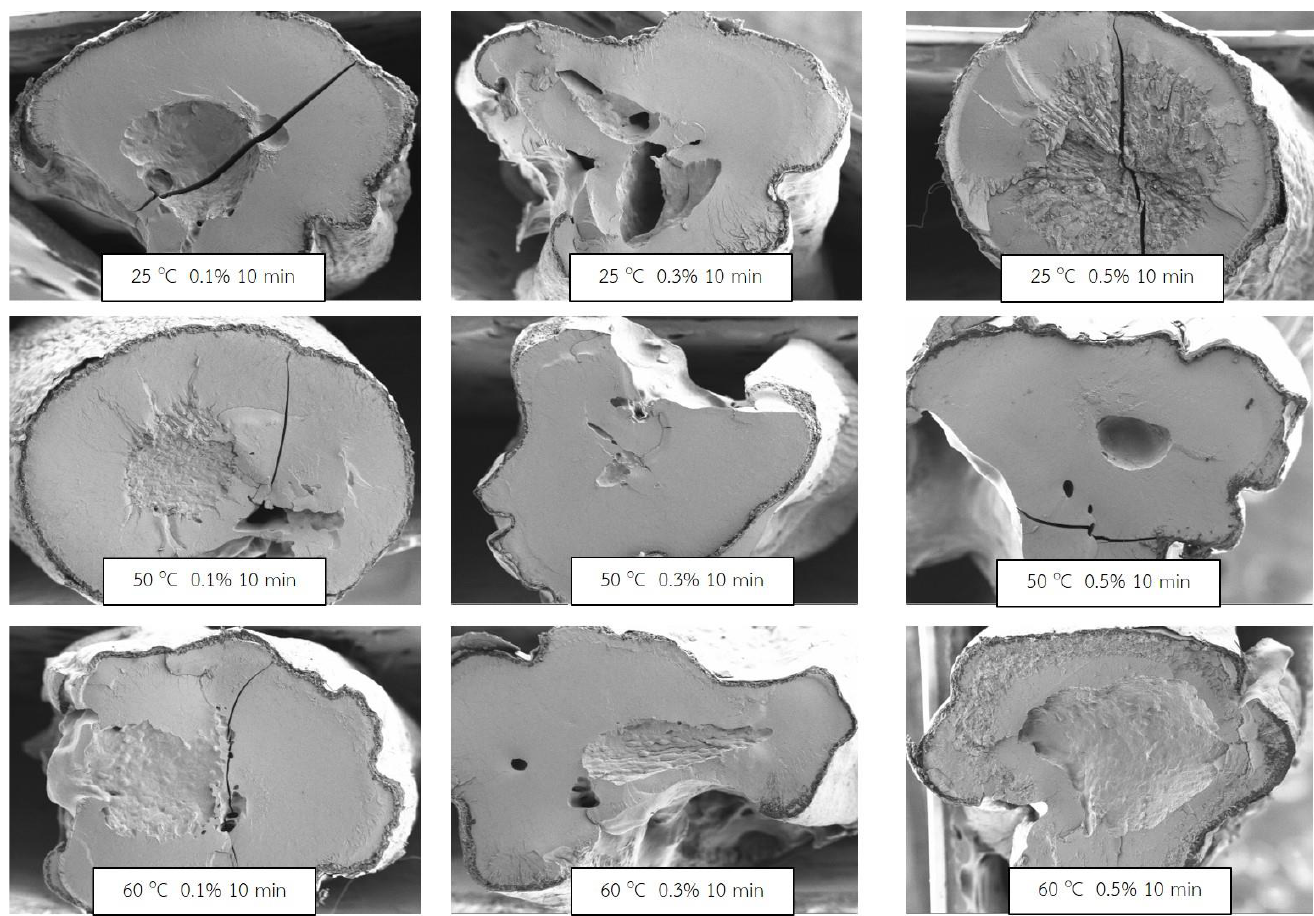
Figure 2. SEM morphology of QBJR sample at the same soaking time of 10 min.